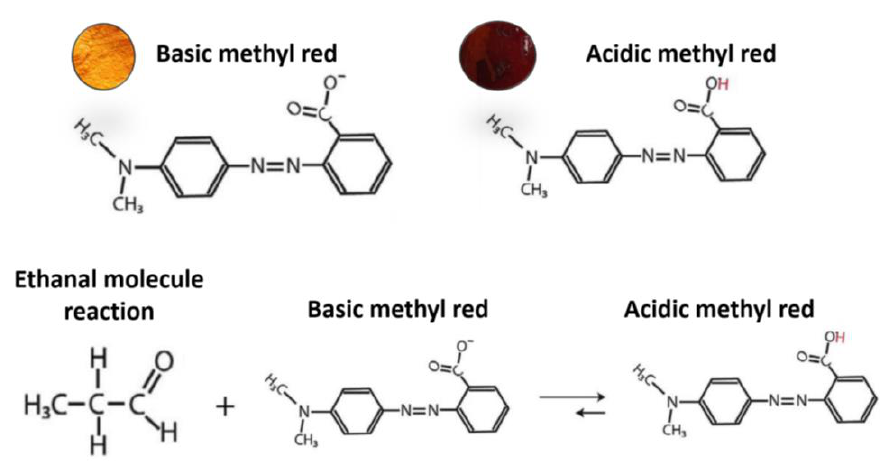
Figure 8. Scheme illustrating the chemical reaction responsible for the color change (adapted from [23].